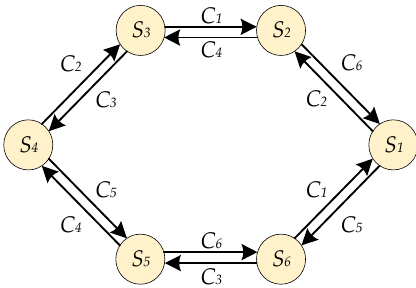
Figure 4. Normal FSM of the PMBLDC motor drive.